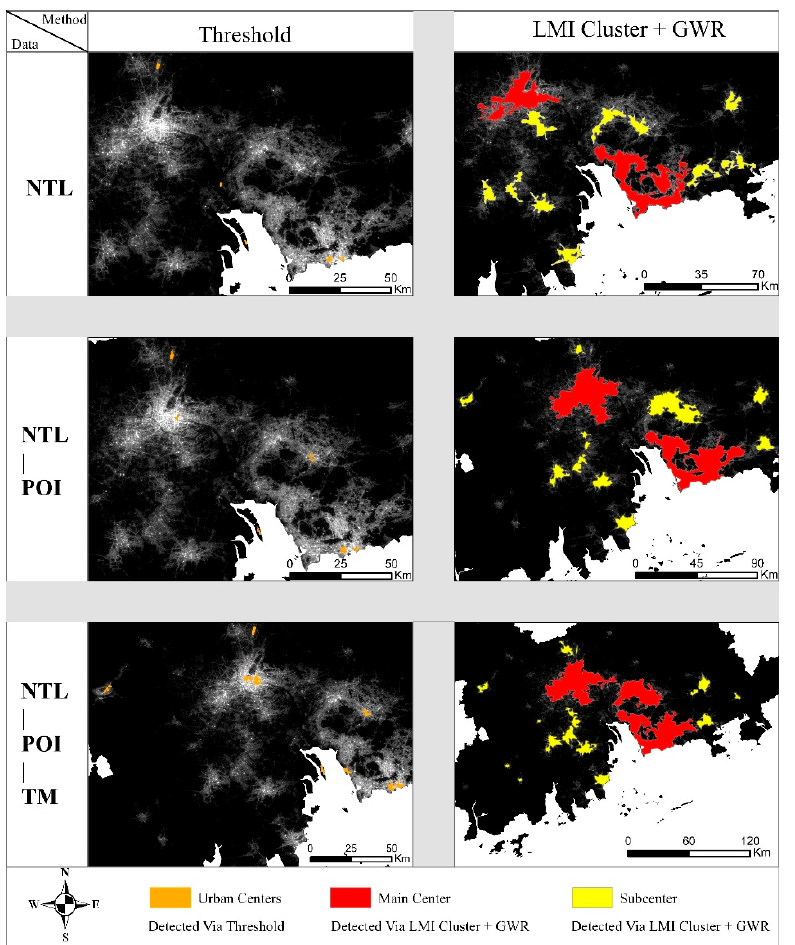
Figure 13. Comparison of urban polycenter results identified by different data and methods (the orange part represents the urban center identified by the relative threshold, the red part represents the main center identified by LMI, and the yellow part represents the city subcenter identified by GWR).